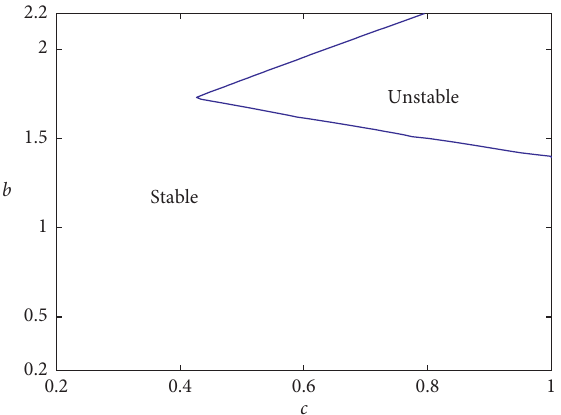
Figure 6: The phase diagrams of system (10) with the initial condition x discrete time evolution of the state variable x ( n ) with c � 0 . 40, (g) c � 0 . 87, and (h) c � 0 . 88.